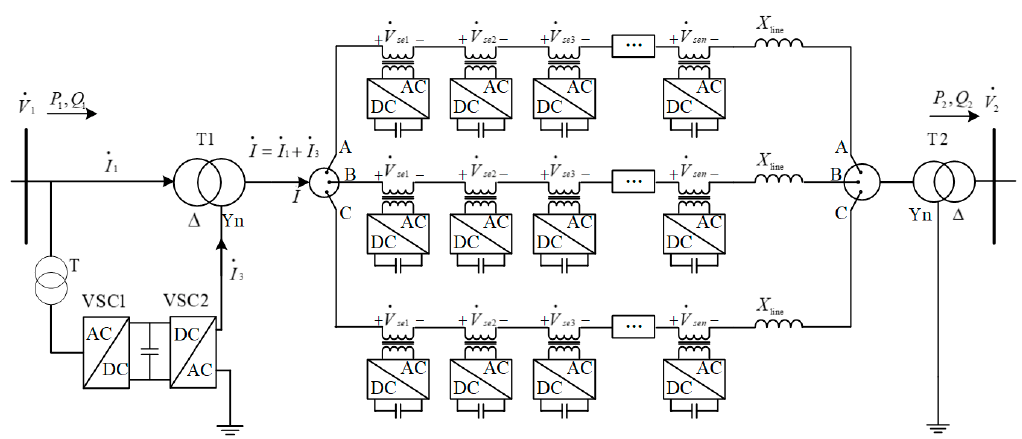
Figure 1. Structure of a distributed power flow controller (DPFC).